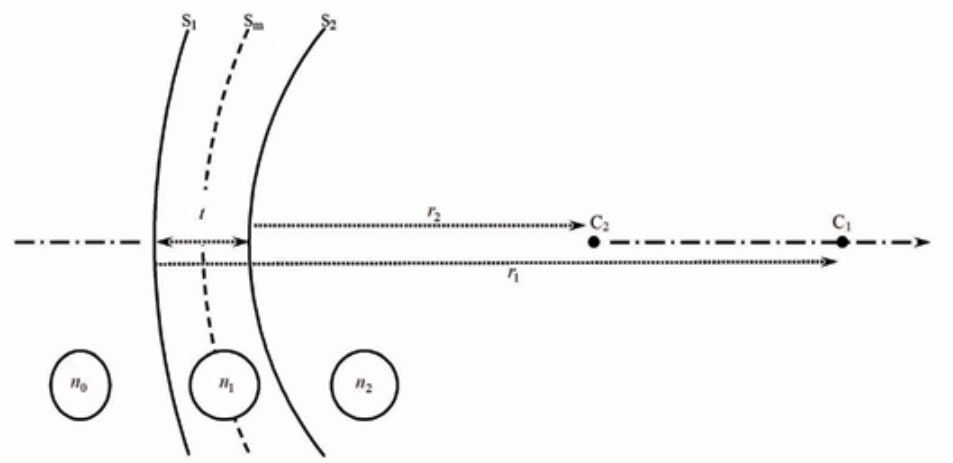
and S . C and C are the centres of curvature of the 1 2 1 2